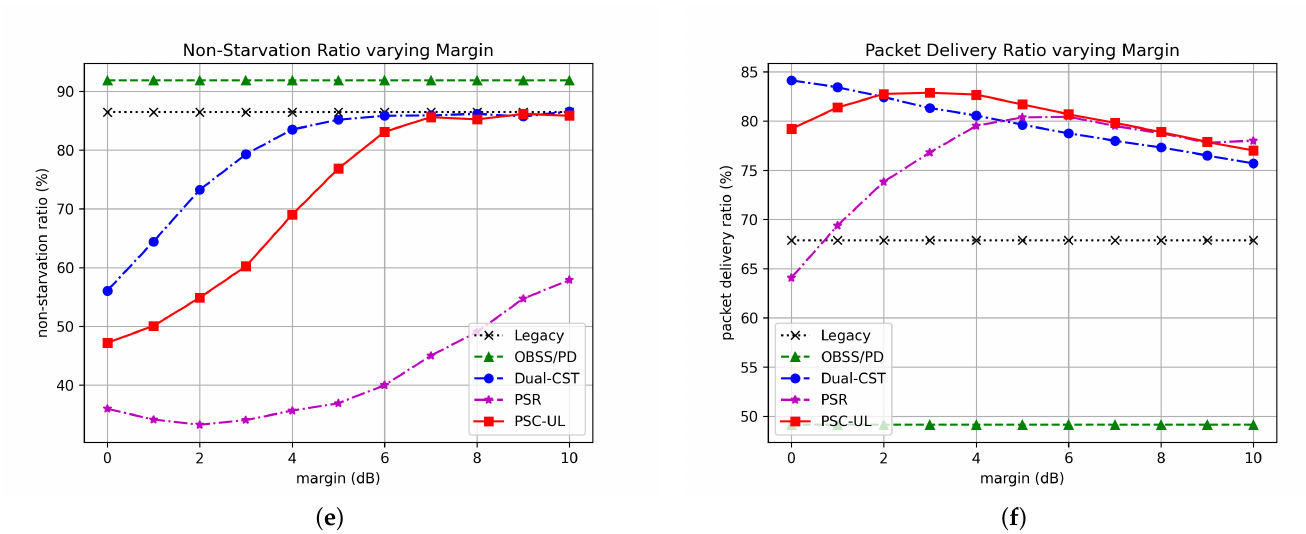
Figure 12. Performance of methods varying margin. ( a ) Total throughput; ( b ) Bottom 50% throughput; ( c ) Bottom 25% throughput; ( d ) Fairness; ( e ) Non-starvation Ratio; ( f ) Delivery